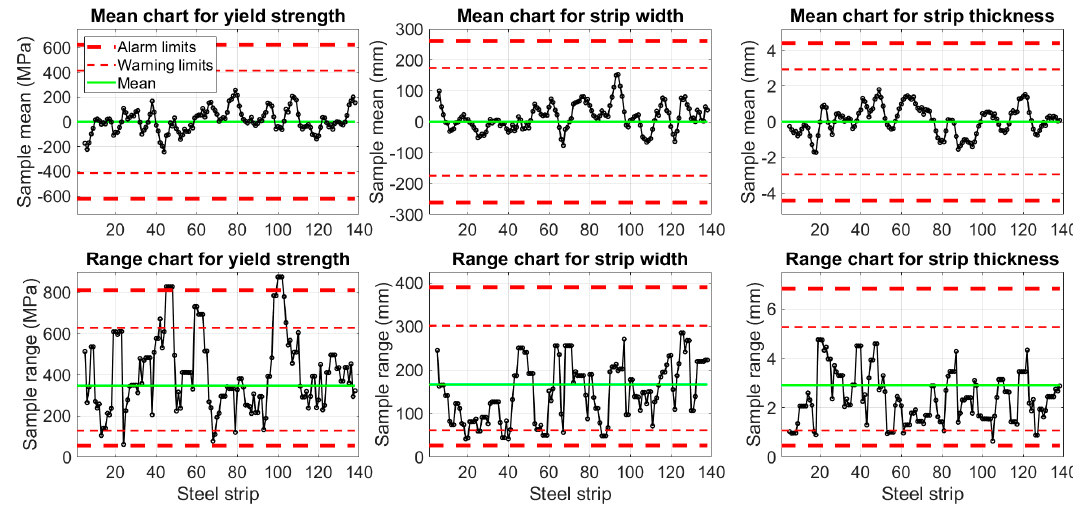
Figure 14. Roller leveler monitoring based on moving mean and range charts using the external validation points.